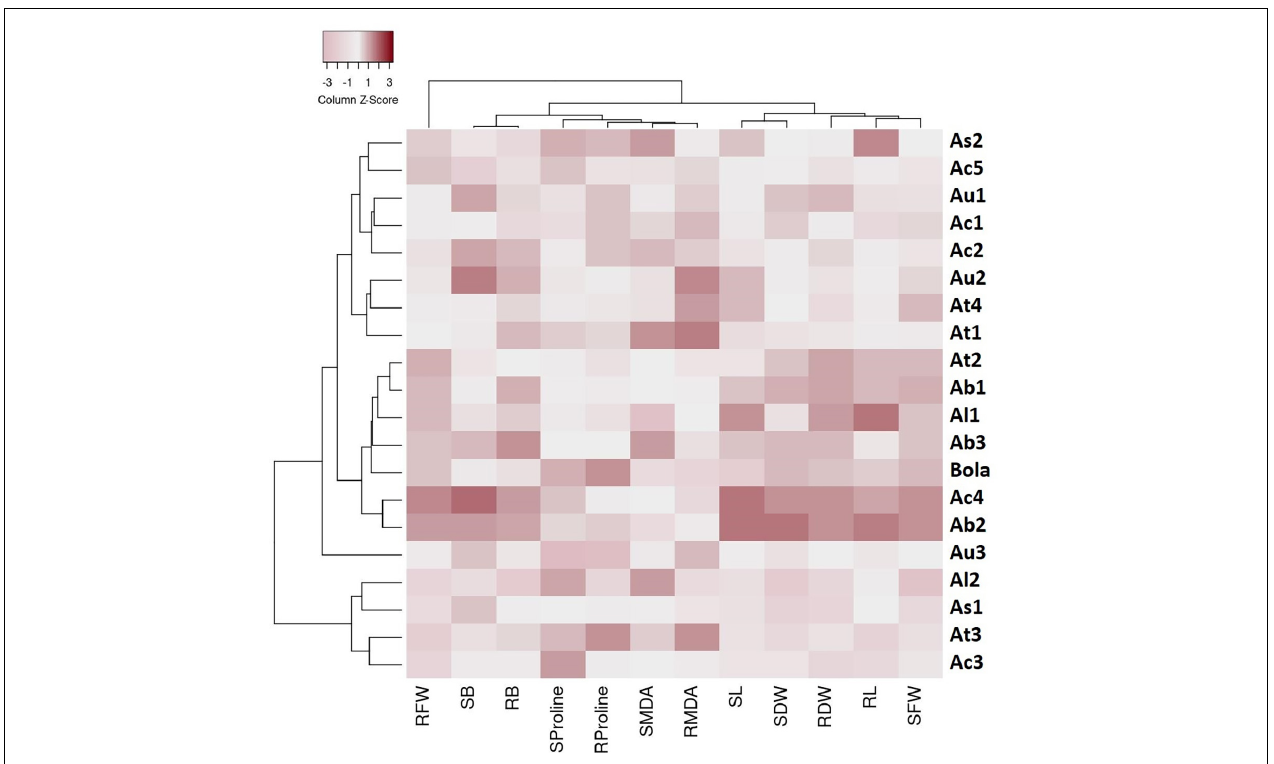
FIGURE 2 | A heat map describing the boron (B) toxicity stress-induced genetic variability in traits among 19 Aegilops accessions and the check cultivar, Bolal 2973 grown under B toxicity in the hydroponic system. The color code signifies the Z score for each genotype: dark color specifies an increase in the percentage of the trait values of the genotypes under B toxicity as compared to Control, whereas a lighter shade specifies the decrease in the percentage of the trait values of the genotypes under B toxicity as compared to Control. The genotypes were clustered into three different groups (C1–C3) based on their response to B toxicity stress in terms of different traits, including root length (RL), shoot length (SL), RFW (root fresh weight), shoot fresh weight (SFW), root dry weight (RDW), shoot dry weight (SDW), root malondialdehyde (RMDA), shoot malondialdehyde (SMDA), root proline (RProline), shoot proline (SProline), root boron (RB accumulation), and shoot boron (SB